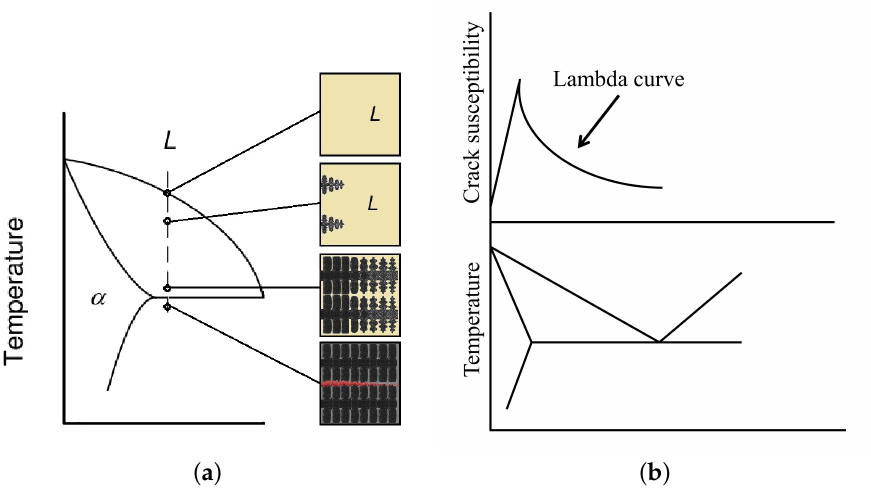
Figure 1. Solidification cracking in materials as a consequence of microstructure and solidifica- tion range. ( a ) Solidification regime in two-phase region of aluminum with a columnar dendritic structure. An intergranular crack is shown in lower microstructure, marked in red. ( b ) Solidification crack susceptibility as a function of alloy composition, and solidification range for an arbitrary binary eutectic alloy. Reproduced with permission from Song et al., Journal of Magnesium and Alloys; published by Elsevier, 2016